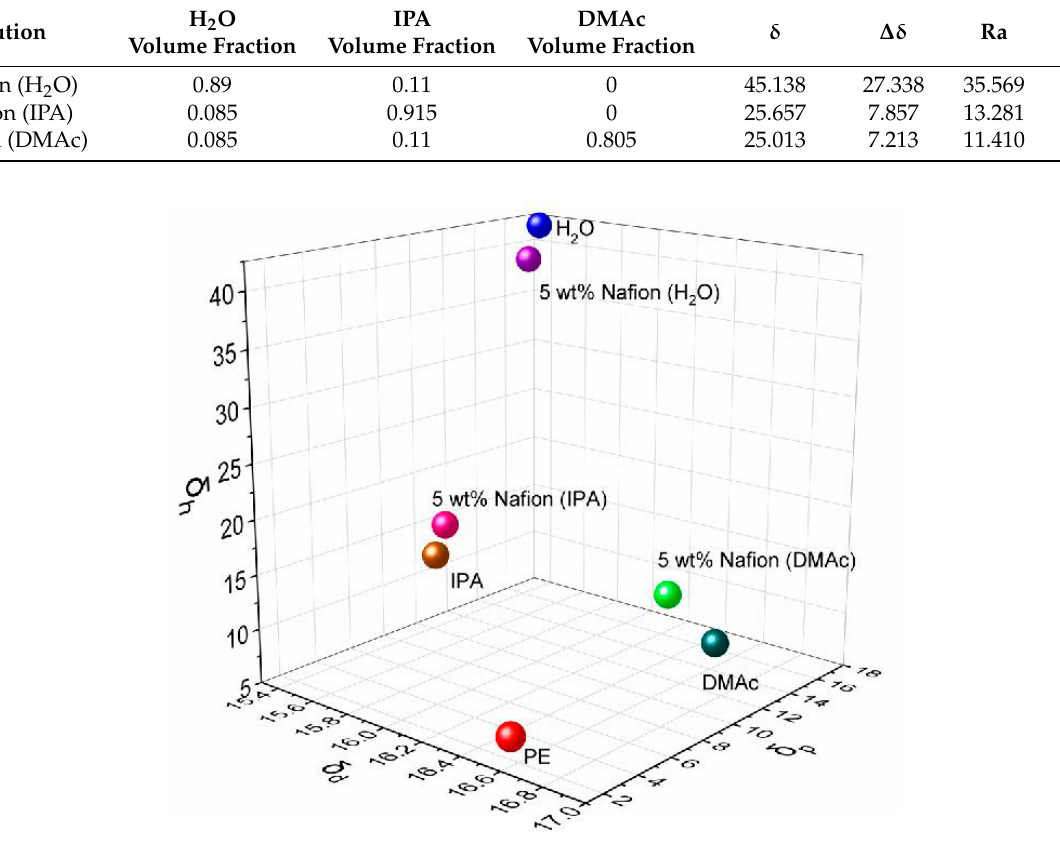
Figure 2. Solubility parameter of the different solution. In general, when the Ra value of the mixed solvents is less than Ro of the polymer, this solvent is referred to as a “good” solvent and will dissolve or swell the polymer. That is, the difference between Ra and Ro determines their affinity. As shown in Table 1, the difference (Ra-Ro) from the mixed solvent of D-DMAc is the smallest, which is consistent with the solubility parameter difference ( ∆ δ ). Meanwhile, the solvent composition of D-DMAc is the closest to the “solubility circle” (Figure 2) of PE, while that of D-H 2 O is far away from the circle. Namely, the affinity between the mixed solvents and PE is in the order of D-DMAc-PE > D-IPA-PE > D-H 2